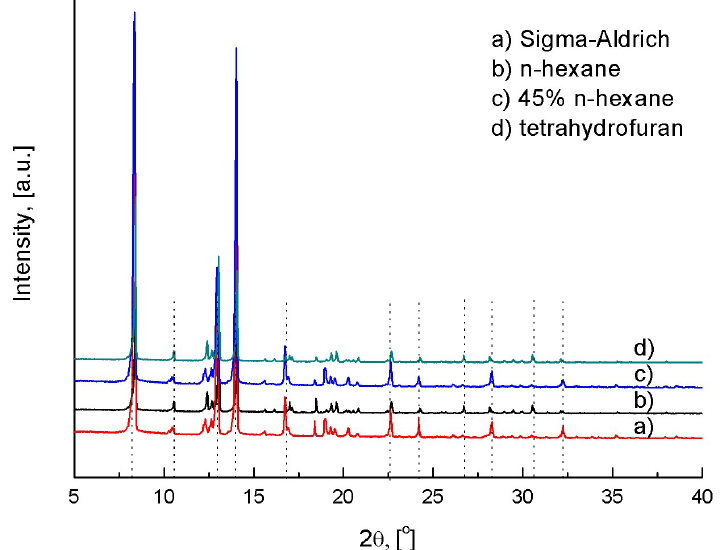
Figure 2. XRD patterns of L-lactide species recrystallized in n-hexane, tetrahydrofuran, and the mixed solvent.